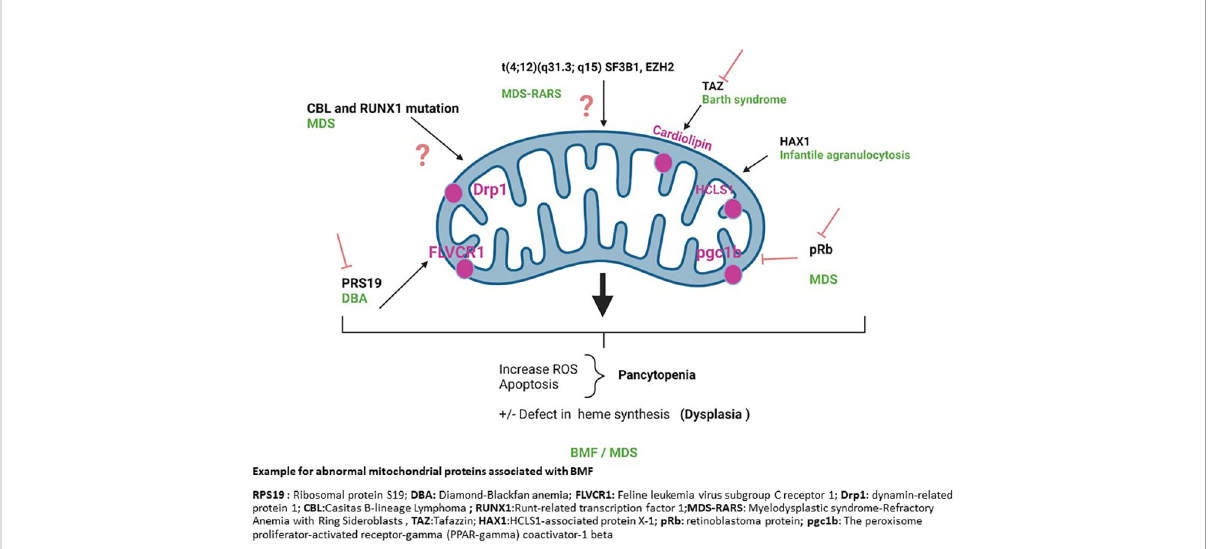
FIGURE 1 Example for abnormal mitochondrial proteins associated with BMF. RPS19, Ribosomal protein S19; DBA, Diamond-Blackfan anemia; FLVCR1, Feline leukemia virus subgroup C receptor 1; Drp1, dynamin-related protein 1; CBL, Casitas B-lineage Lymphoma; RUNX1, Runt-related transcription factor 1; MDS-RARS, Myelodysplastic syndrome-Refractory Anemia with Ring Sideroblasts, TAZ, Tafazzin; HAX1, HCLS1-associated protein X-1; pRb, retinoblastoma protein; pgc1b, The peroxisome proliferator-activated receptor-gamma (PPAR-gamma) coactivator-1